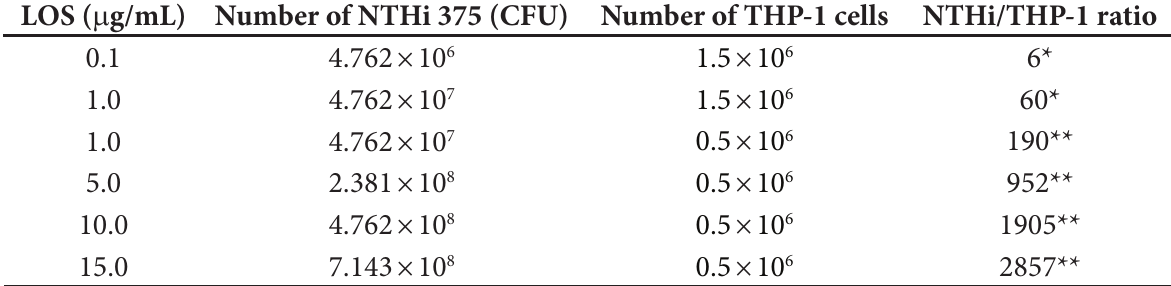
Table 1. Estimated numbers of bacteria corresponding to LOS doses used in this study. * Gene expression analysis (qPCR), ** Surface molecule expression (flow cytometry and ELISA analysis) LOS ( µ